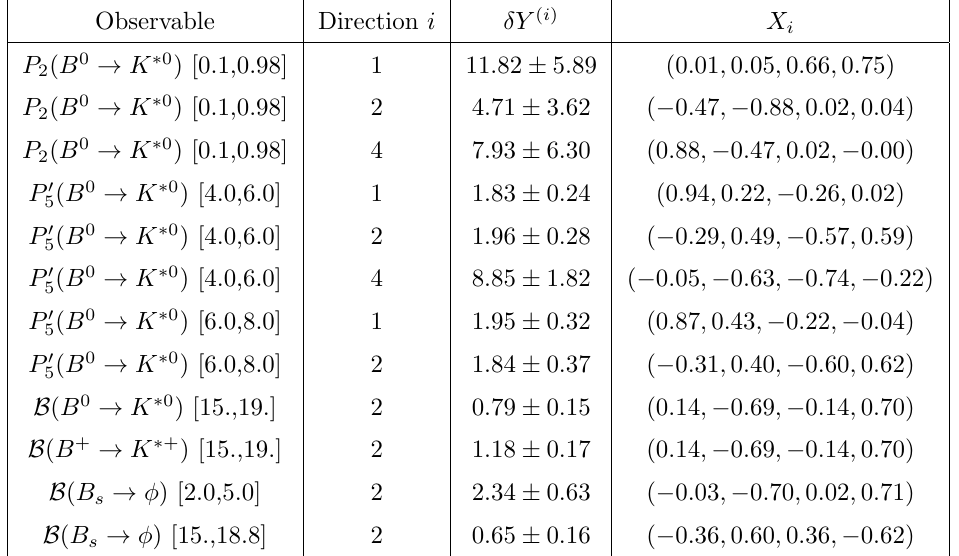
Table 1. Distance (cid:14)Y ( i ) from the SM to the LFD conic conic section. The last column indicates the vector corresponding to the main axis i in the basis X = ( ; ; 0 (cid:22) ; 0 (cid:22) C 9 (cid:22) C 10 (cid:22) C 9 C 10